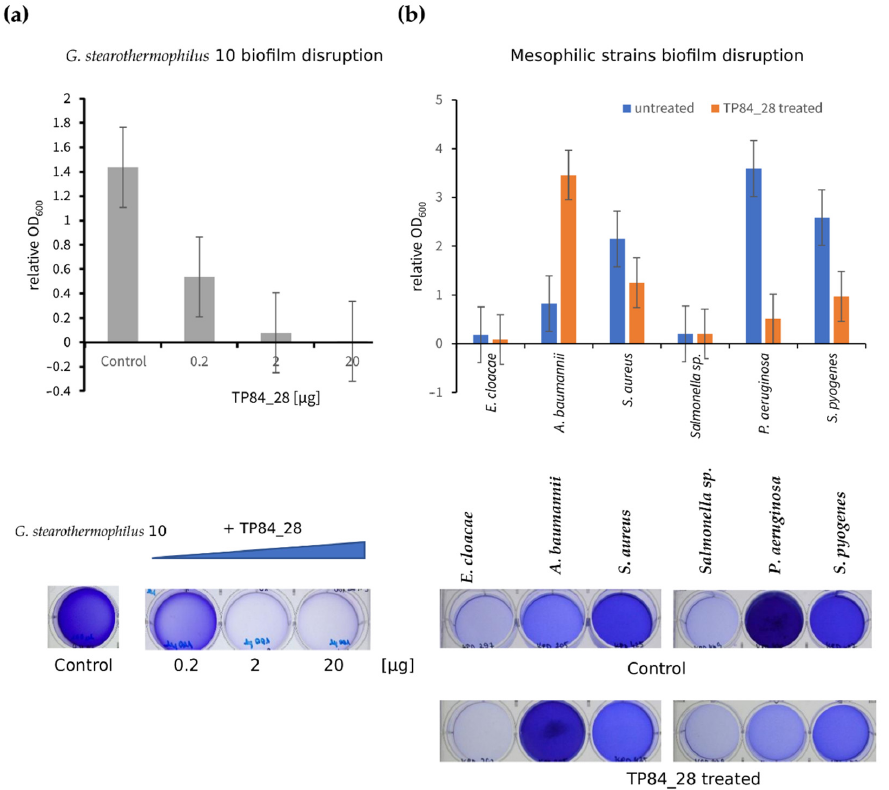
Figure 6. Disruption of bacterial biofilms. ( a ) G. stearothermophilus strain 10 biofilm disruption.